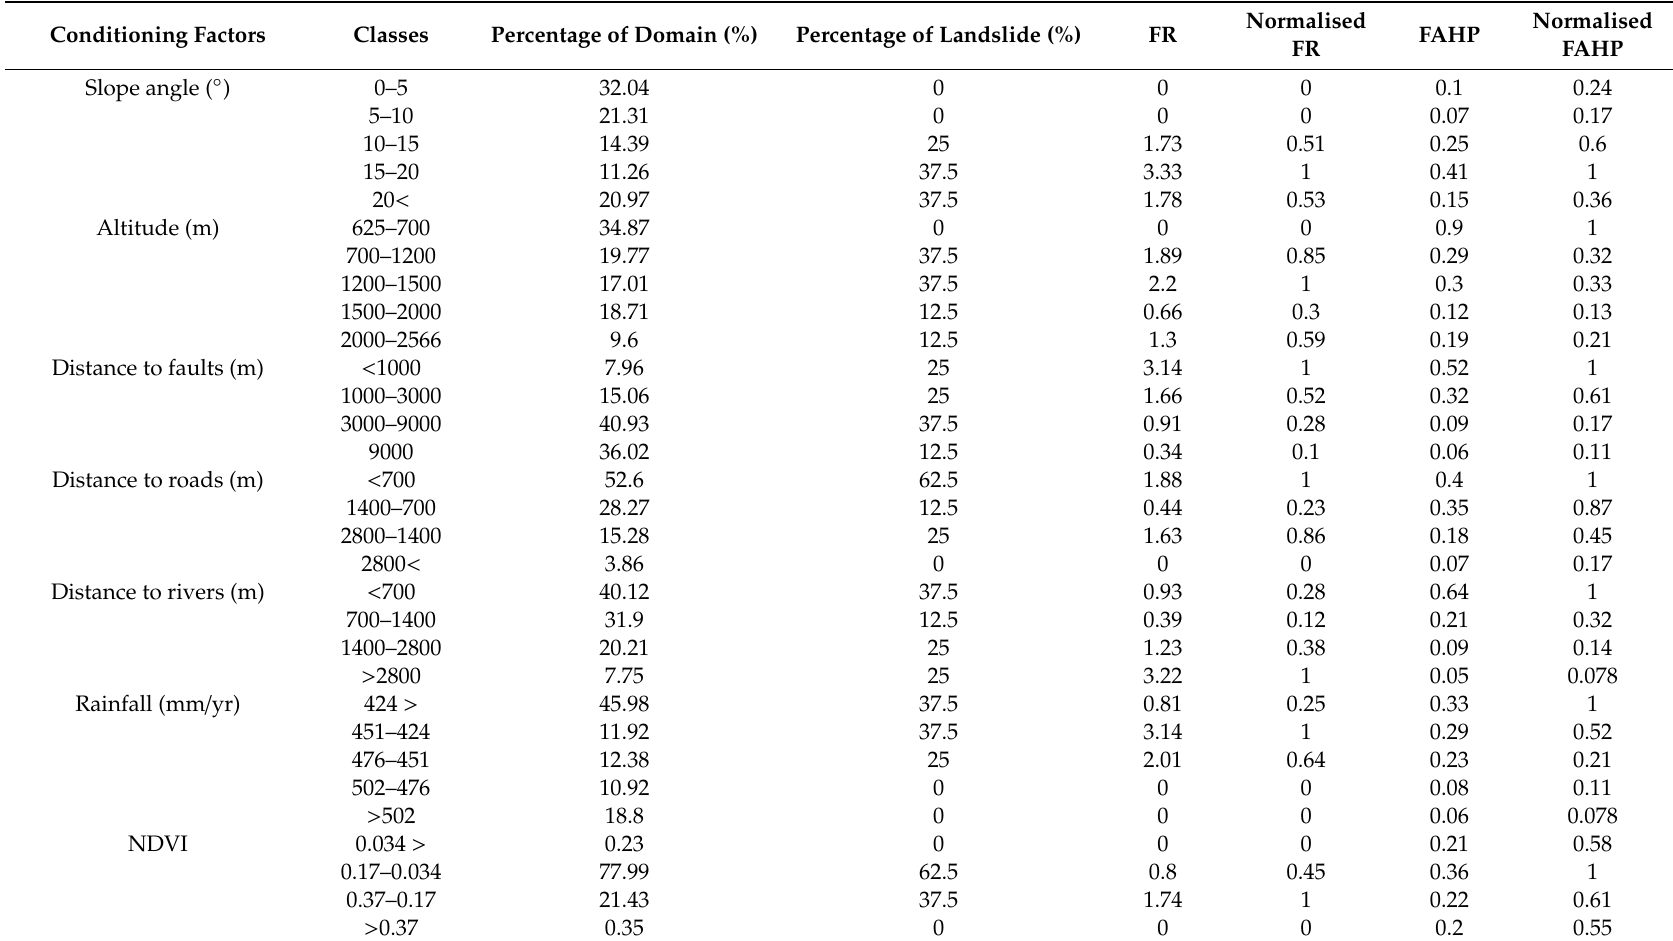
Table 5. The normalised weights of each conditioning factor based on each